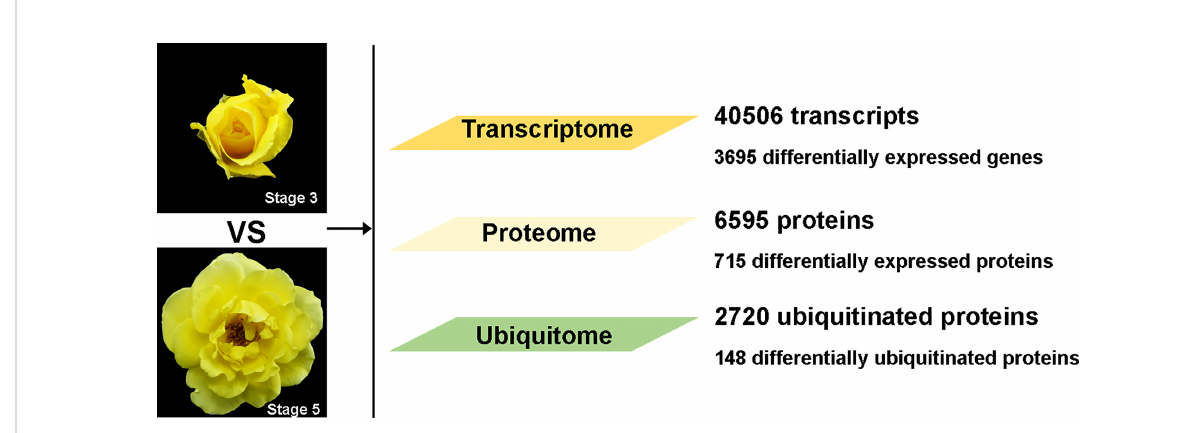
FIGURE 1 Overall data for transcriptome, proteome, and ubiquitome in petal AZ at fl ower opening stages 3 and